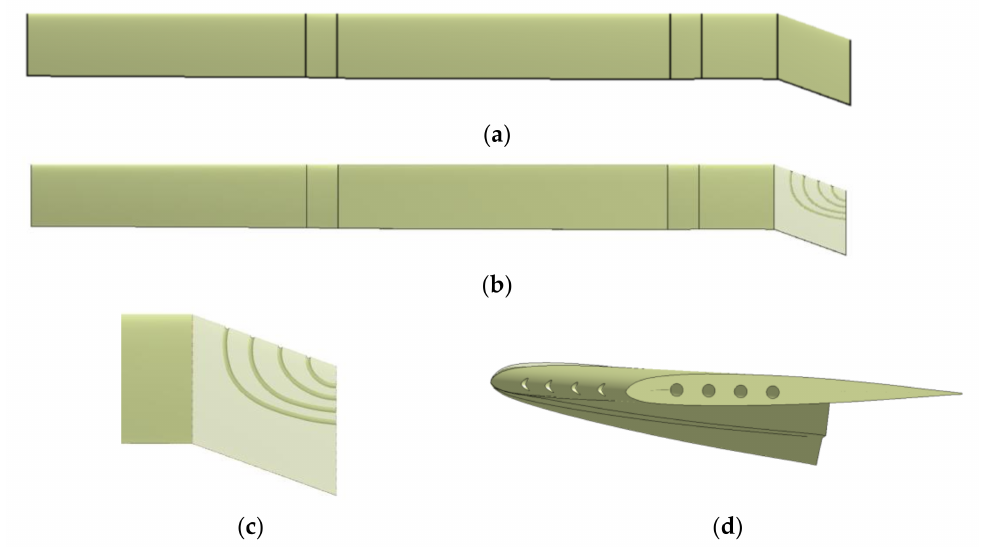
Figure 20. Slotted-tip rotor model. ( a ) The reference blade, ( b ) The slotted-Tip blade, ( c ) Local sketch of four circular slots, ( d ) The right view of blade